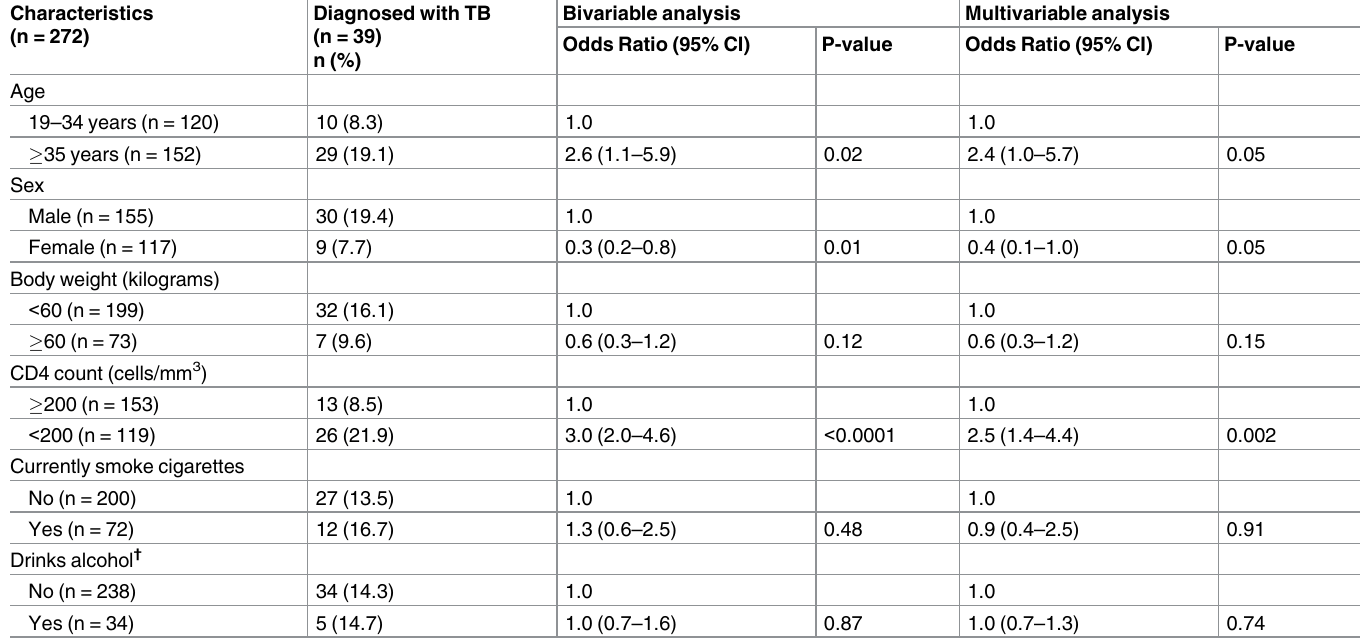
Table 2. Results of generalized estimating equations logistic regression analysis of characteristics of people living with HIV with tuberculosis symptoms * to control for site-levelclustering and to determine predictors of TB disease diagnosis at seven hospitals in Thailand, 2010–2011. Characteristics (n = 272)